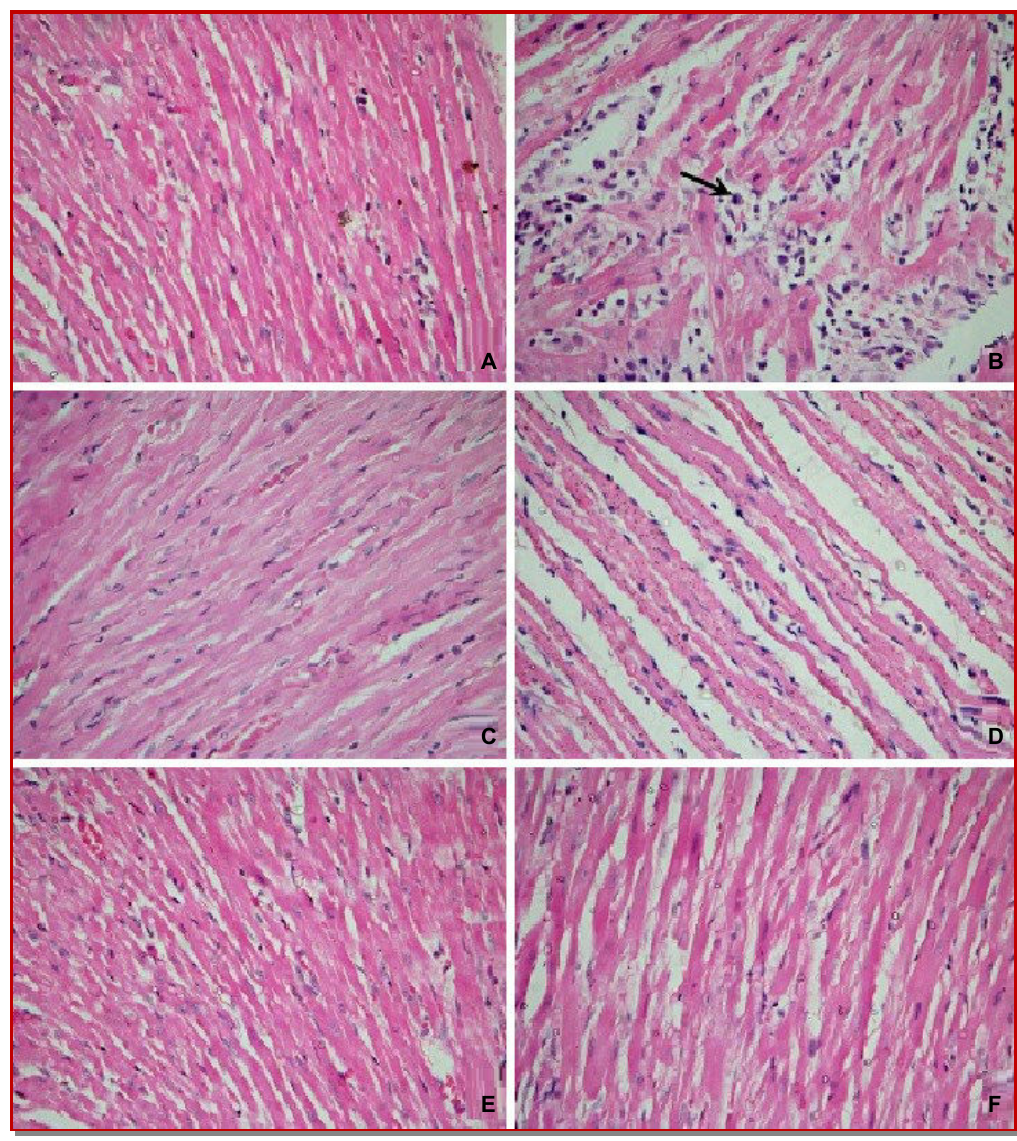
Figure 3: Photomicrographs of Haematoxylin and Eosin staining of heart X400. A) Control rat heart showing normal architecture of myocytes; B) isoproterenol-control group heart showing necrosis of muscle fiber with inflamma- tory cell infiltration, edema along with extravasation of red blood cells; C) coconut sprout (200 mg/100 g) alone treated rat heart showing normal cardiac fibers; D) coconut sprout 50 mg/100 g + isoproterenol showing edema with inflammatory cell infiltration; E) coconut sprout 100 mg/100 g + isoproterenol showing almost normal myocardial cells; F) coconut sprout 200 mg/100 g + isoproterenol treated heart tissue showing mild inflamma- tory infiltration and mild edema but no infarction